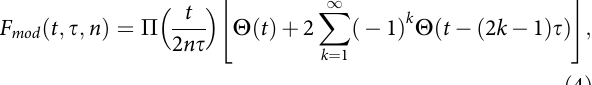
NATURE COMMUNICATIONS|8:14157|DOI: